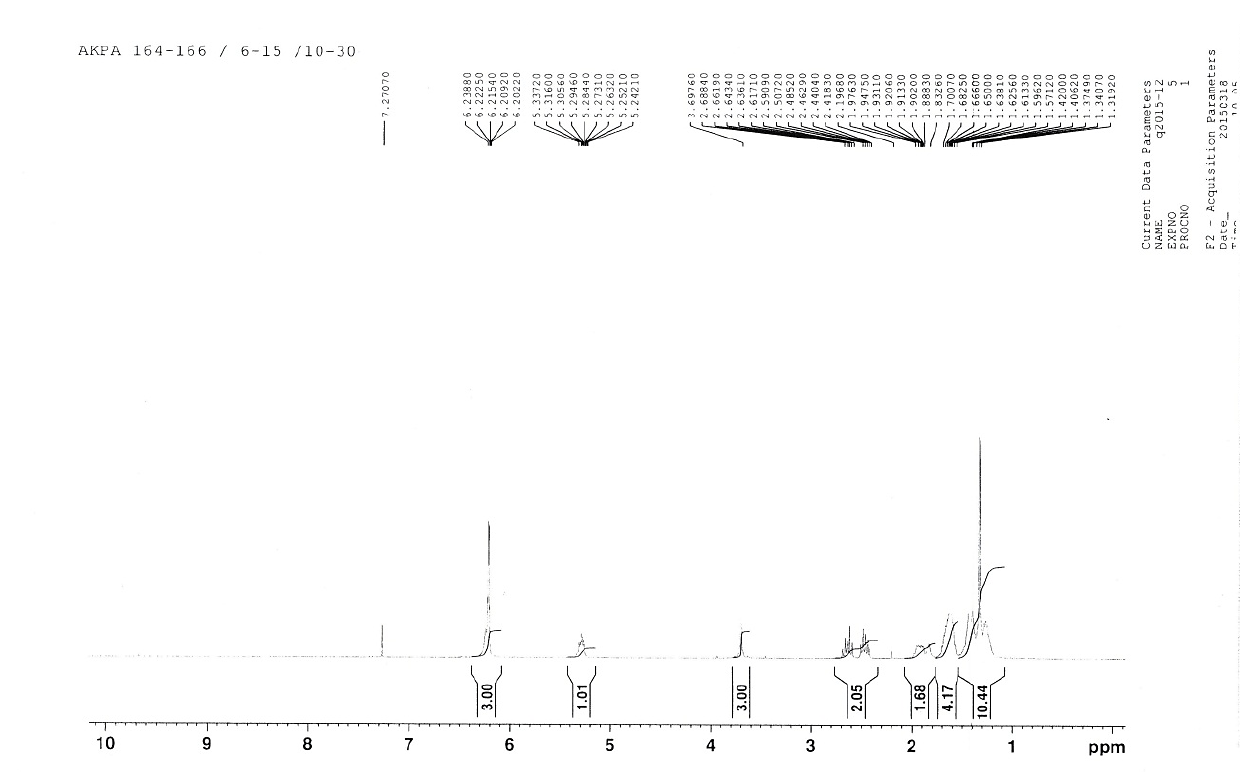
Figure A2. 1 H NMR spectrum of isolated